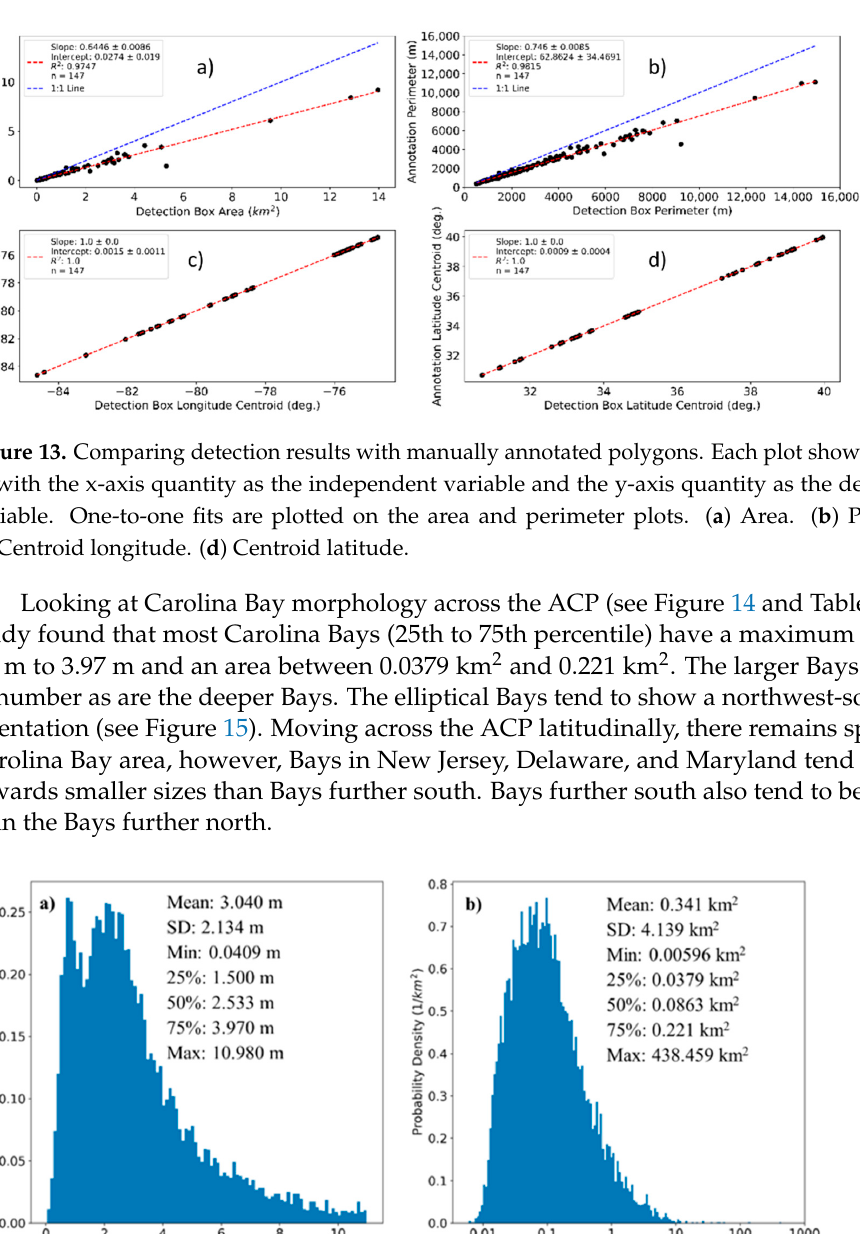
Figure 14. ( a ) Distribution of maximum relief from Carolina Bay detections across the ACP. ( b ) Distribution of area from Carolina Bay detections across the ACP.